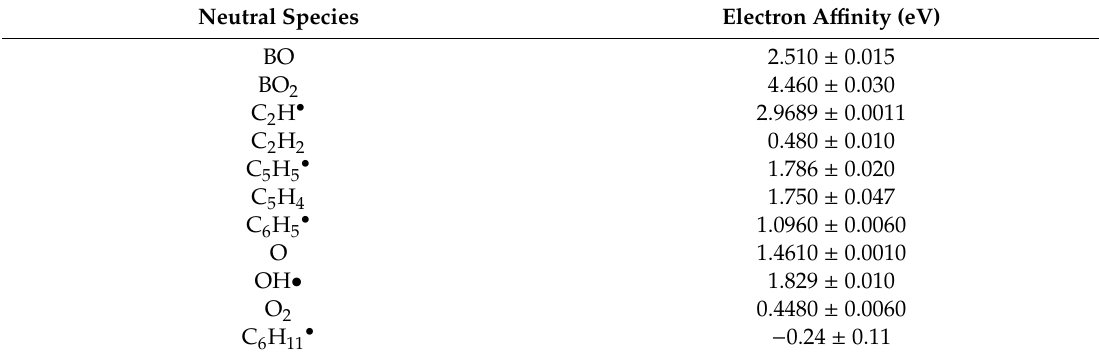
Table 2. Electron a ffi nity of neutral species [19].